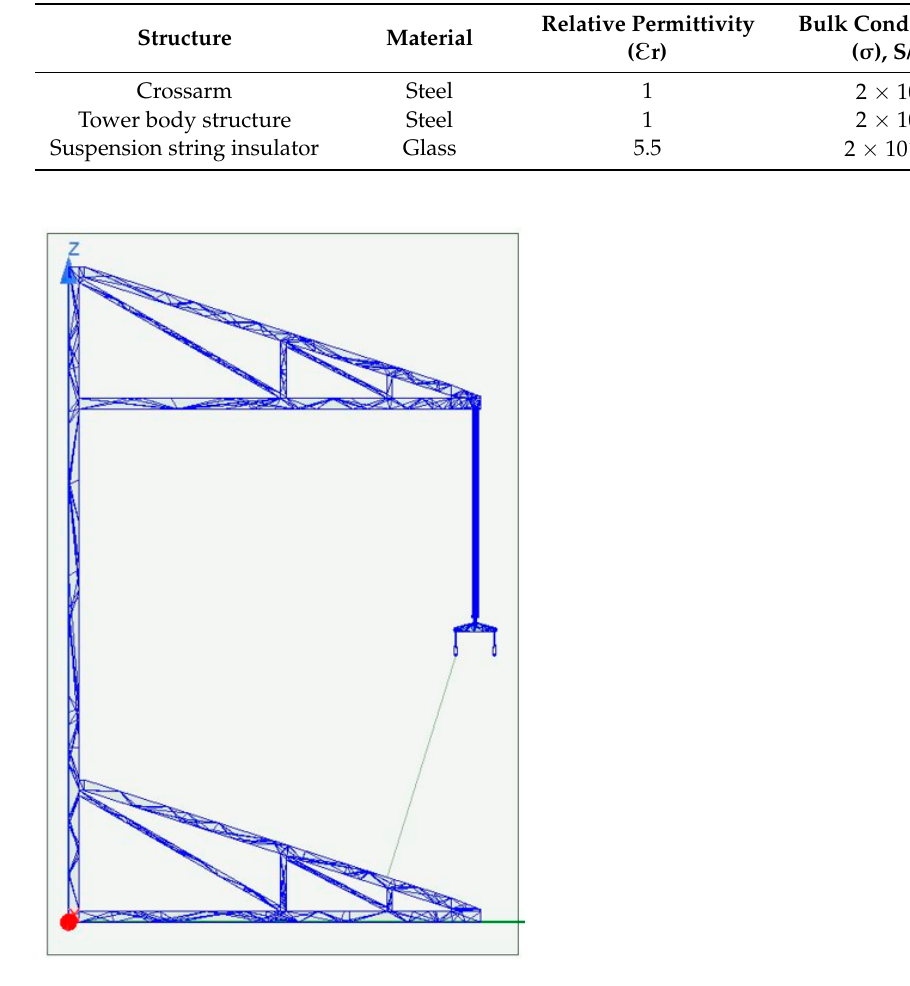
Figure 7. The 2D meshing plot of the proposed voltage uprating model.